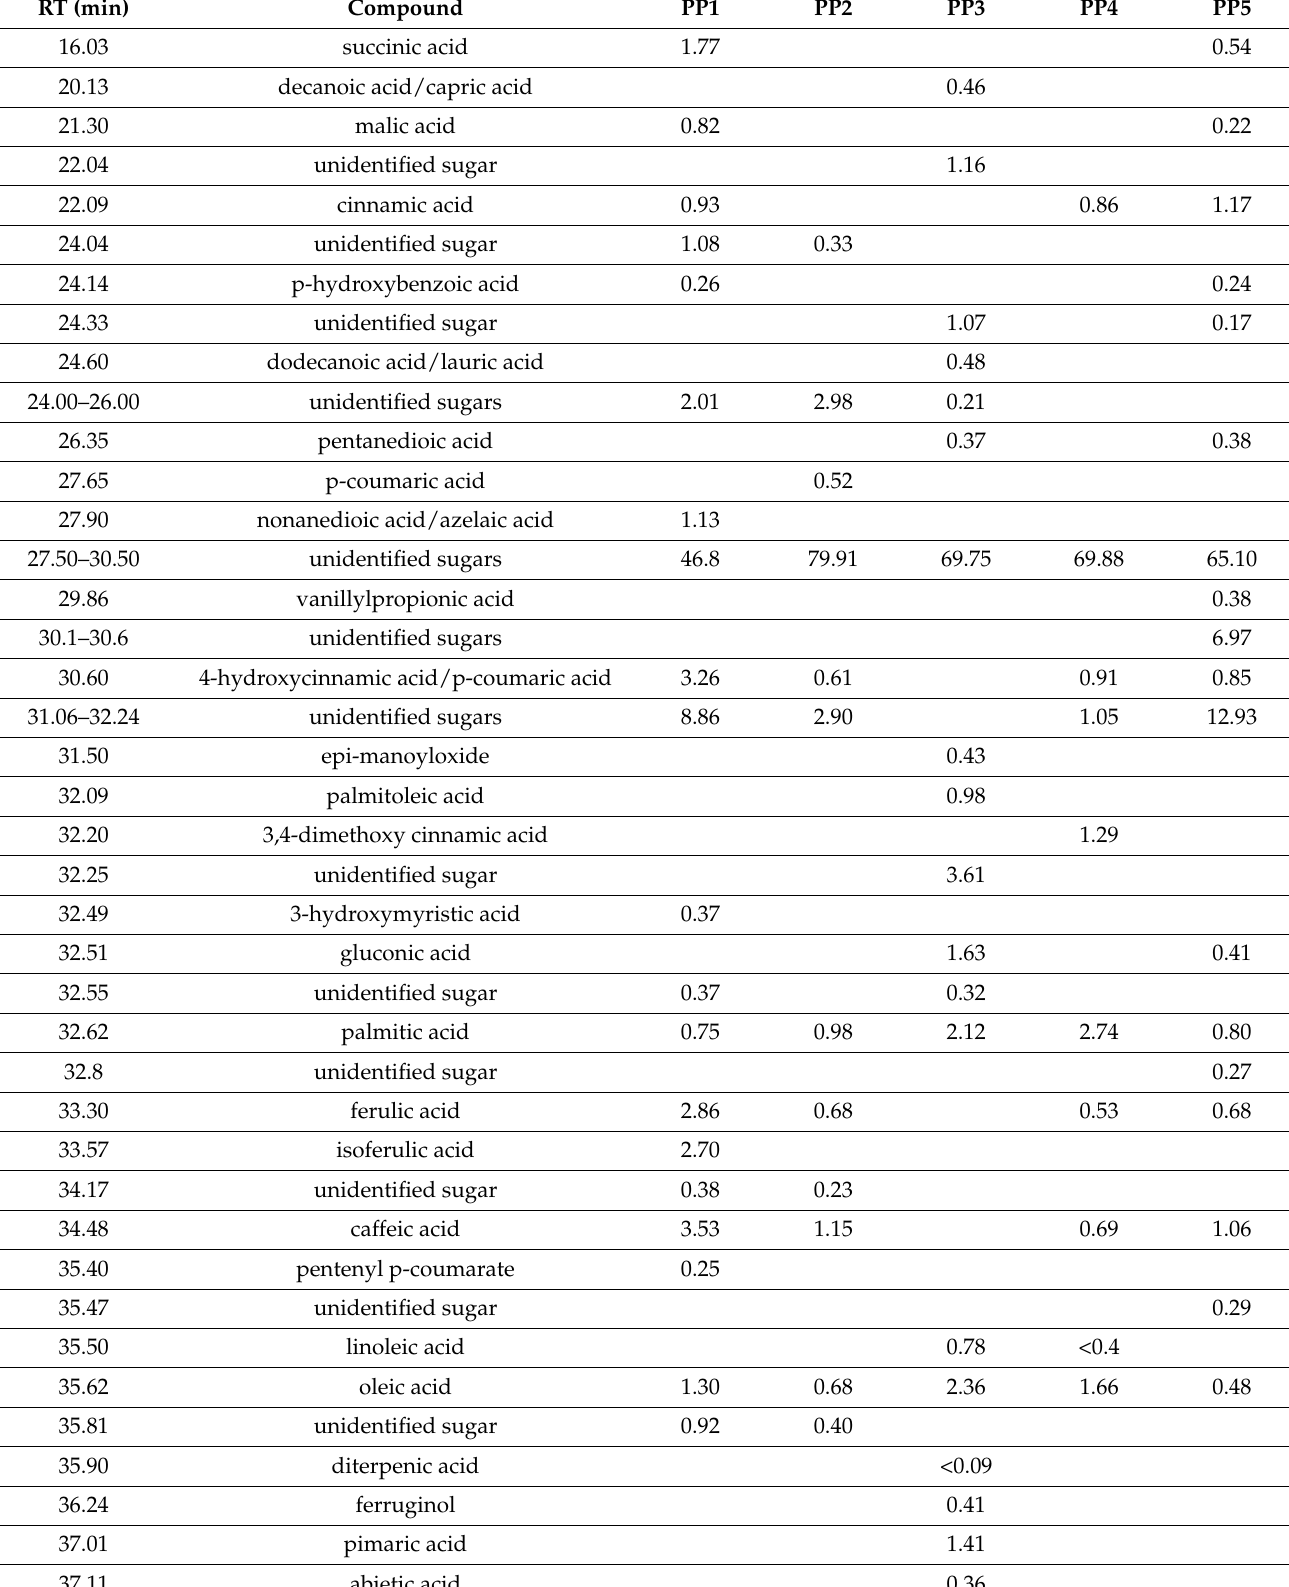
Table 1. Chemical composition by GC-MS analysis of the propolis from the PNP (NW